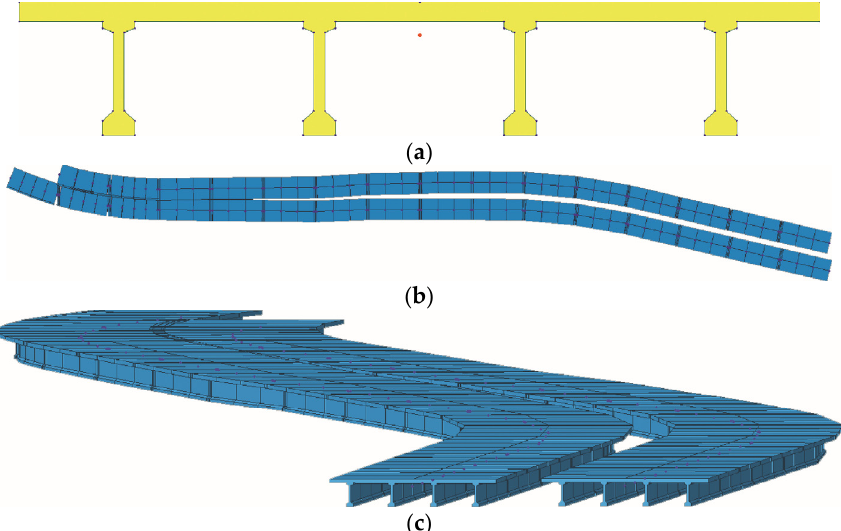
Figure 10. ( a ) Illustration of the beam element model of the bridge deck. ( b ) Plan view of the deck finite element model. ( c ) Perspective view for deck finite element model. finite element model. ( c ) Perspective view for deck finite element model.